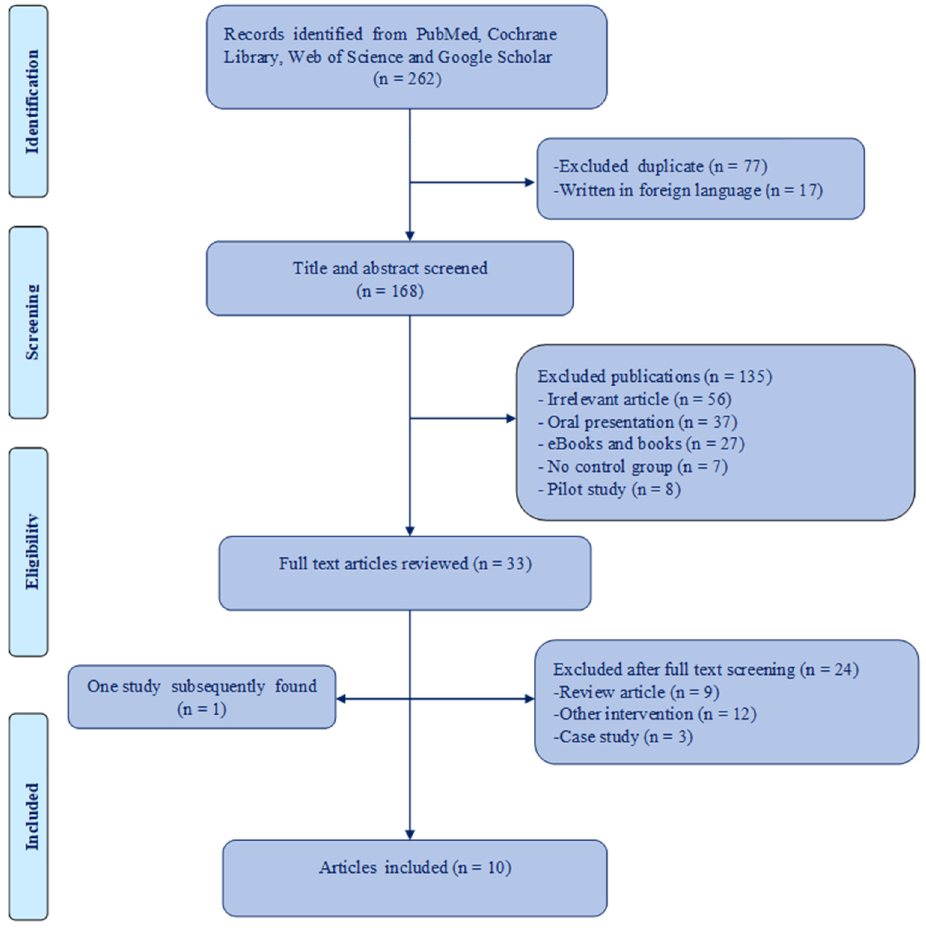
Figure 1. Flow chart of search.